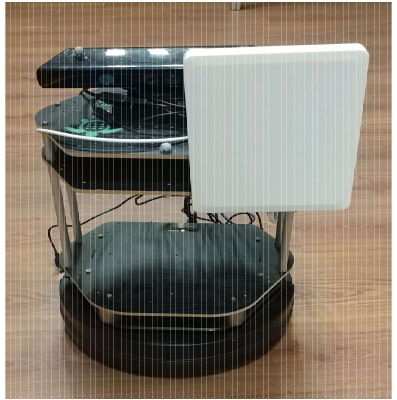
Figure 1. The Turtlebot